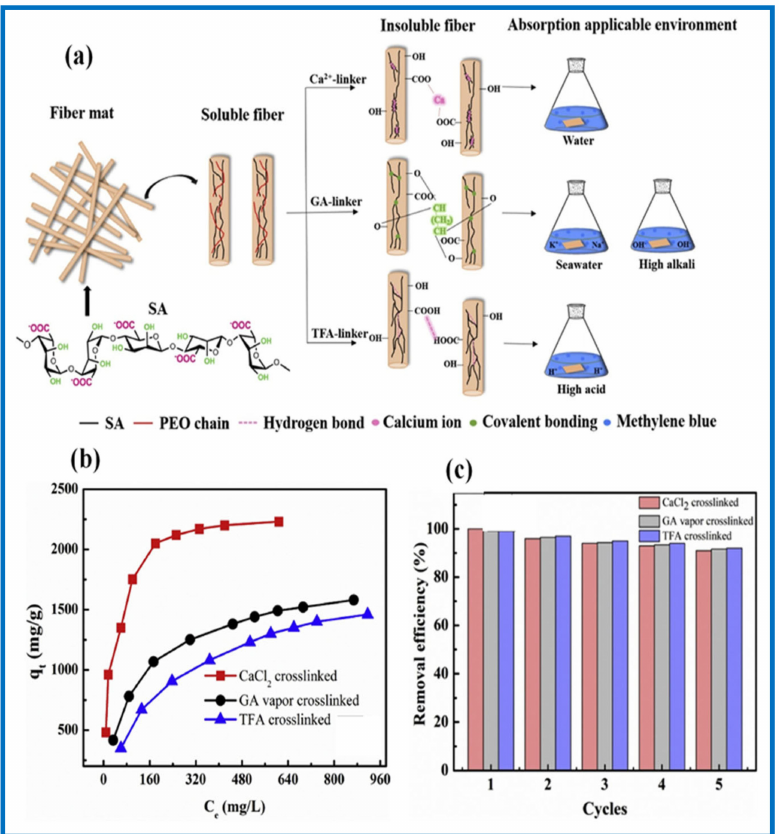
Figure 6. ( a ) Fabrication of sodium alginate /PEO nanofibers and crosslinking by CaCl 2 , GA vapor and TFA ( b ) Adsorption of MB by prepared crosslinked SA/PEO nanofibers ( c ) Reuse of crosslinked SA/PEO nanofibers for adsorption MB [100]. Copyright © (2020) Elsevier. The good selectivity towards the adsorption of MB was attributed to the electrostatic at- traction between the negatively charged ( − SO 3 − ) groups on the surface of PSSNa/PAA@PES and the positively charged MB molecules and vice versa. Dogan et al.